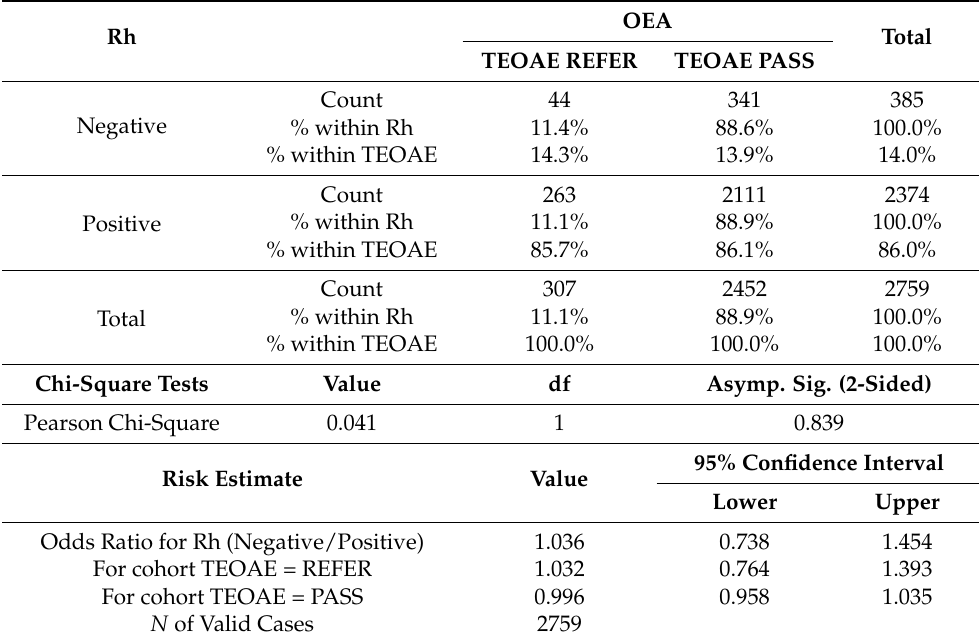
Table 6. Crosstab TEOAE vs.